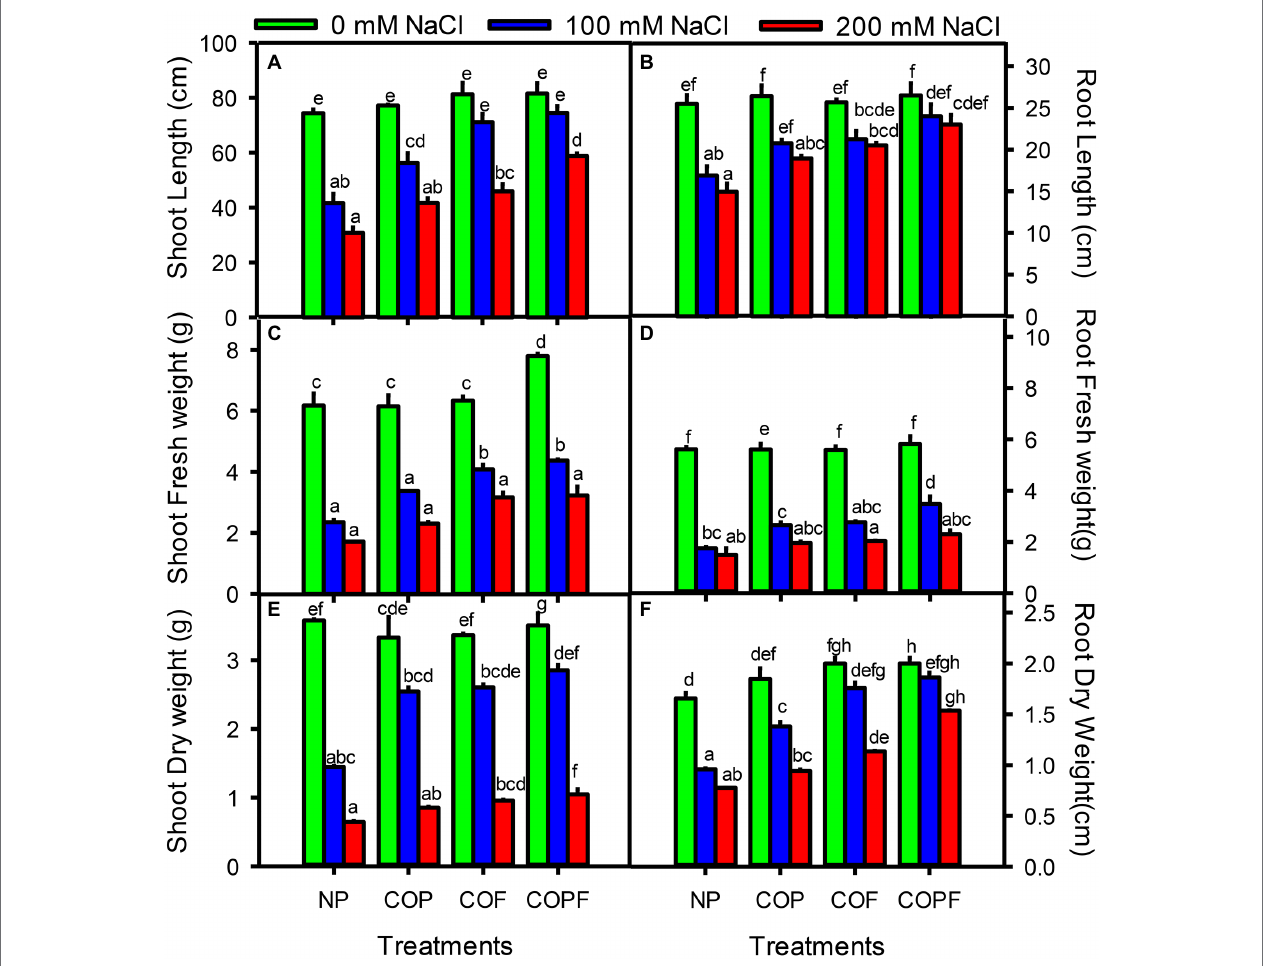
FIGURE 1 | Effect of salinity stress and coumarin applications on growth parameters [Shoot length (A) , Root length (B) , Shoot fresh weight (C) , Root fresh weight (D) Shoot dry weight (E) and Root dry weight (F) ]. Plants were treated with 0 mg L − 1 coumarin (NP), 100 mg L − 1 coumarin as seed priming (COP), 100 mg L − 1 coumarin as foliar application (COF) and combined treatment (COPF), under 0, 100 and 200 mM NaCl. Values are represented as means ±SE ( n = 3). Different letters represent significant differences ( p < 0.05) by Tukey’s HSD